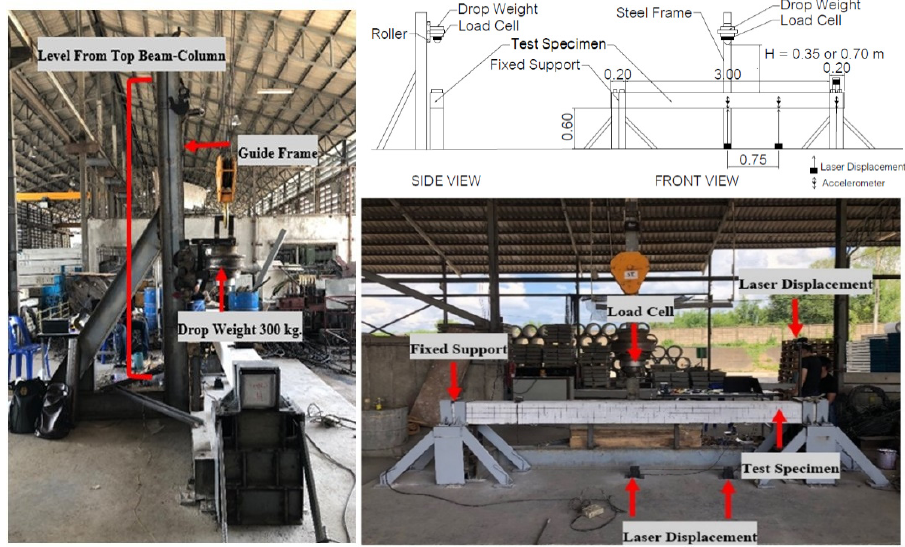
Figure 3. Experimental setup.